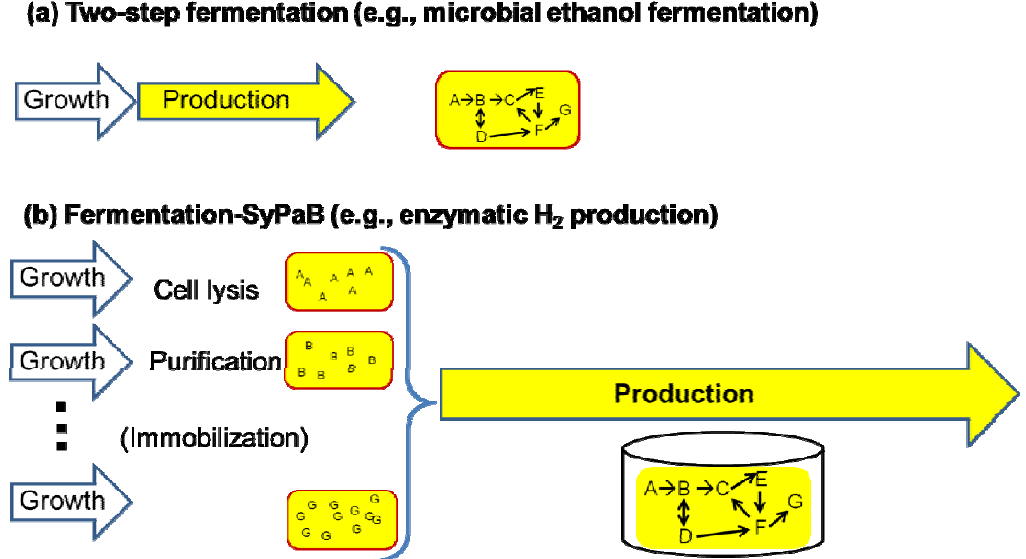
Figure 8 . Process complexity comparison of microbial (ethanol) fermentation involving two steps—microorganism growth and ethanol fermentation ( a ) and a typical SyPaB involving protein production by microbial fermentation, protein purification and/or immobilization, and biotransformation by using the stabilized enzyme mixture ( b